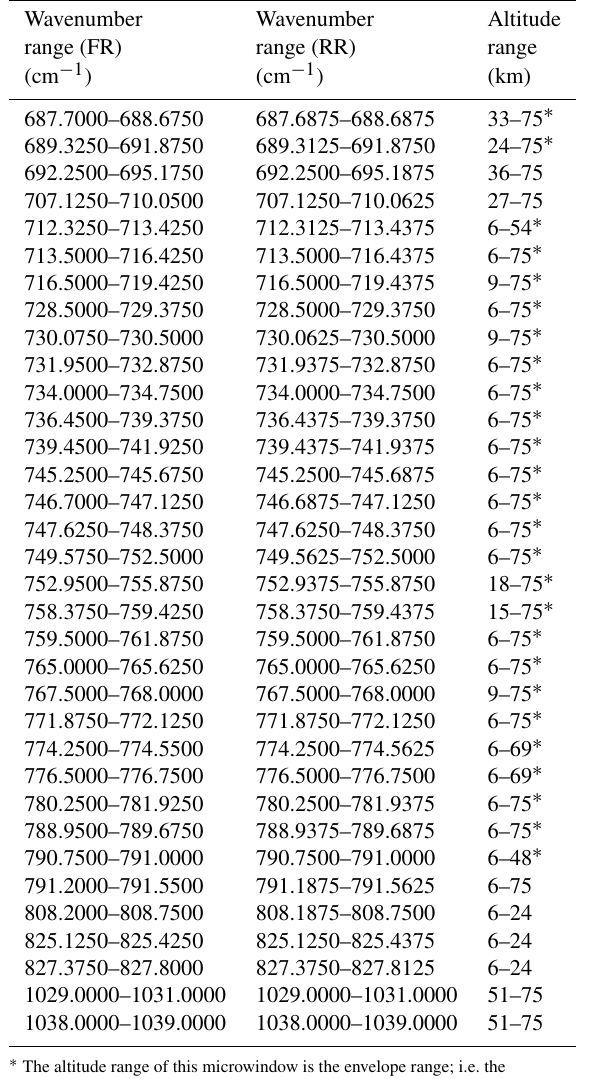
Table 1. Microwindows used in the MIPAS NOM O 3 retrieval. Wavenumber Wavenumber range